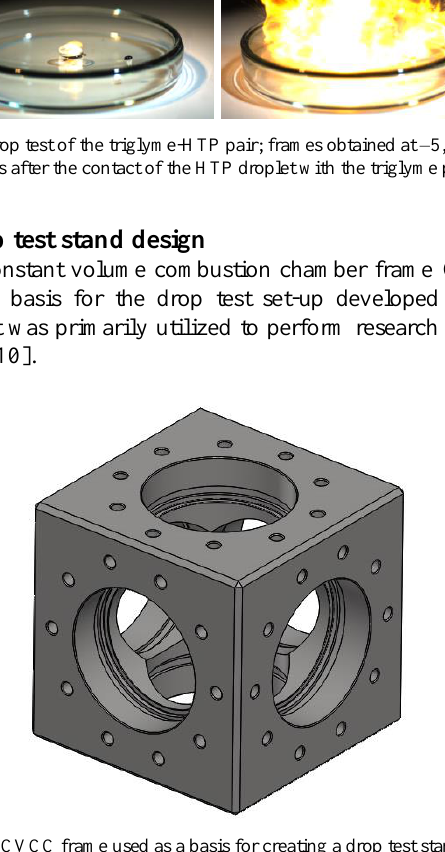
Fig. 5. CVCC frame used as a basis for creating a drop test stand for research in low and high-pressure environments